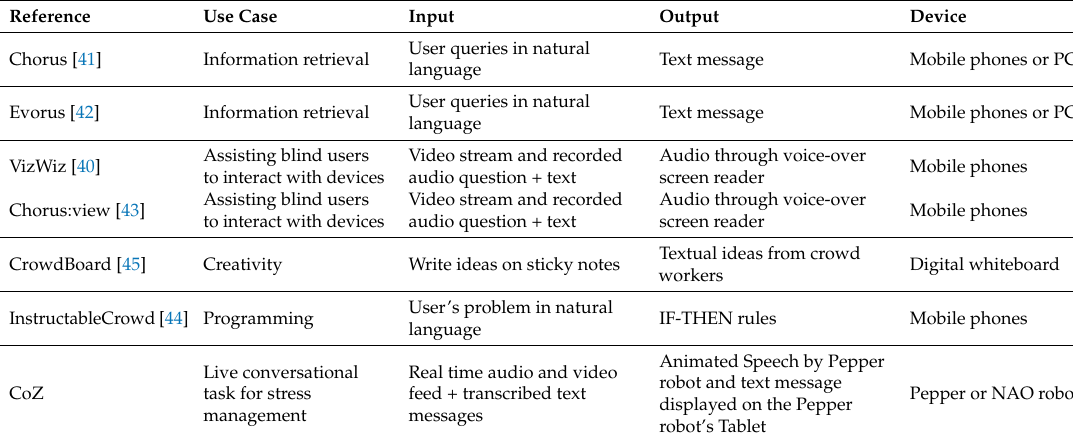
Table 1. Summary of the key differences between Crowd of Oz (CoZ) and other crowd-powered conversational